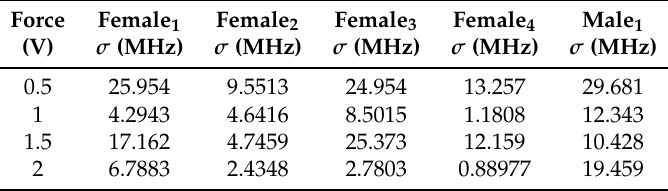
Table 6. Standard deviation from the mean ( σ ) on each applied force